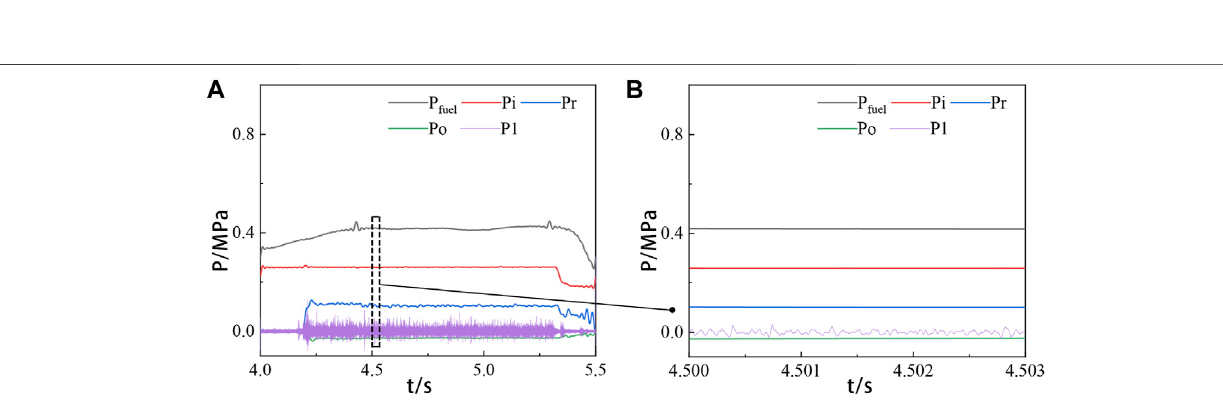
FIGURE 10 | Results of operating at T 0 (cid:1) 562K, _ m air (cid:1) 1 . 5kg/s, and φ (cid:1) 0 . 98. (A) The FFT frequency distribution by PCB 1 ; (B) The STFT frequency distribution by PCB 1